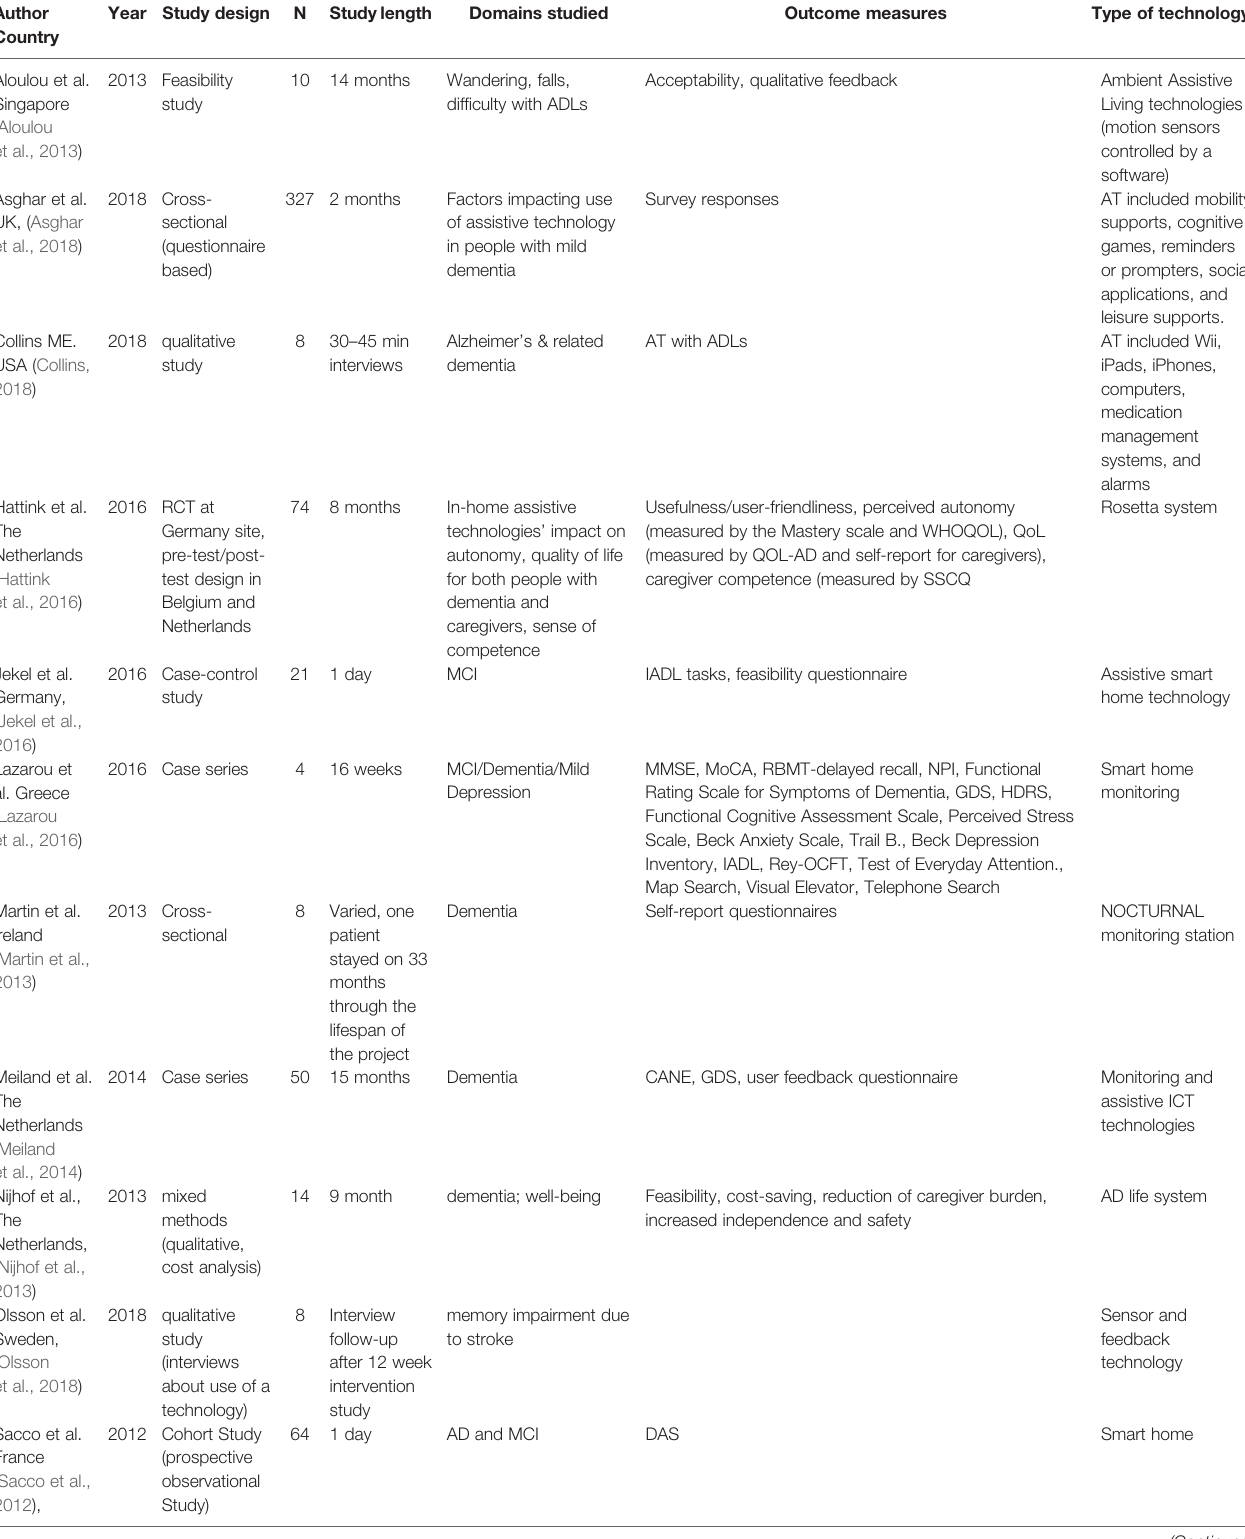
TABLE 4 | Studies utilizing assistive